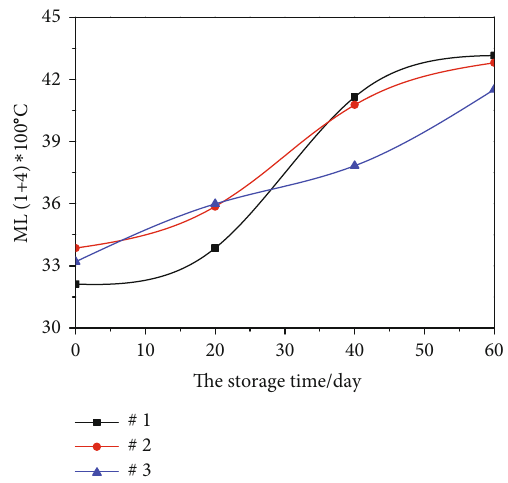
Figure 4: The Mooney viscosity variation of the reclaimed rubber compounds prepared for revulcanization with storage time. The Mooney viscosity values of these compounds are signi fi cantly lower than that of the as-prepared reclaimed rubber samples (Figure 2), and their Mooney viscosity is less a ff ected by the storage.